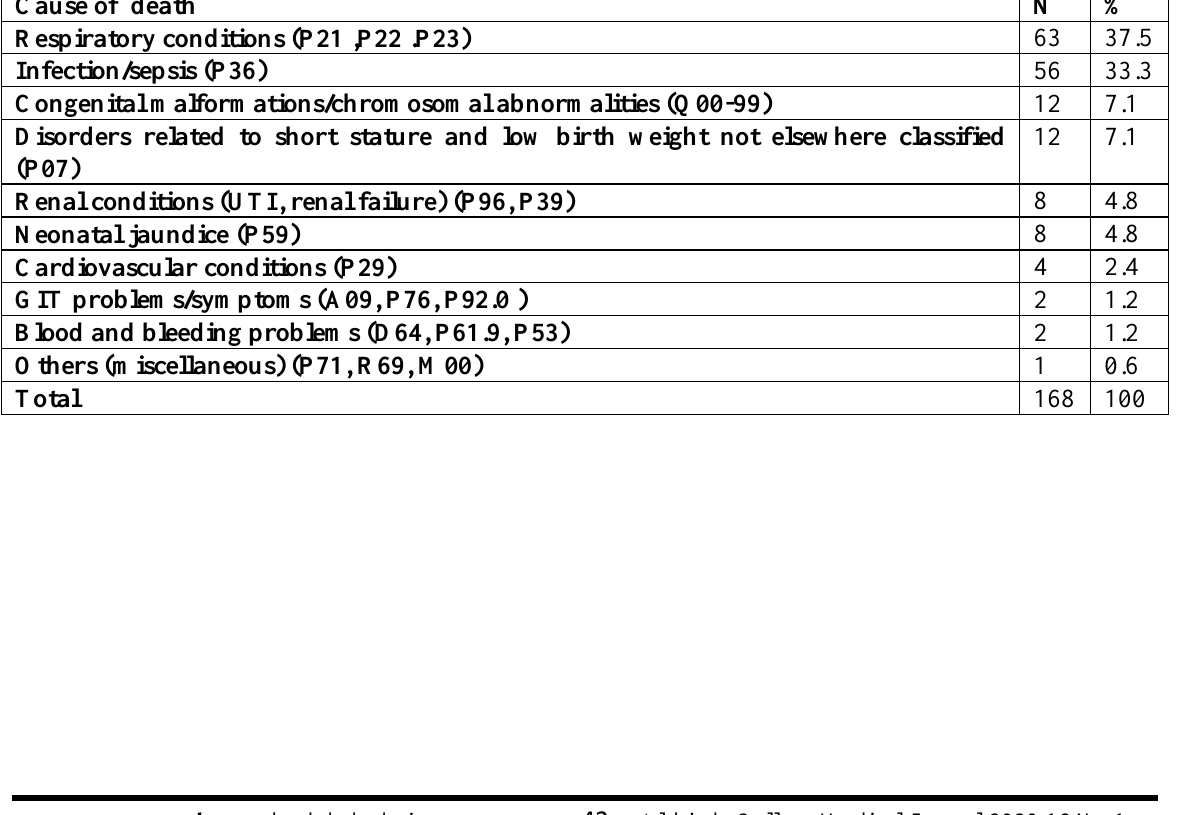
Table 4: Cause of death ratio Cause of death N Respiratory conditions (P21 ,P22